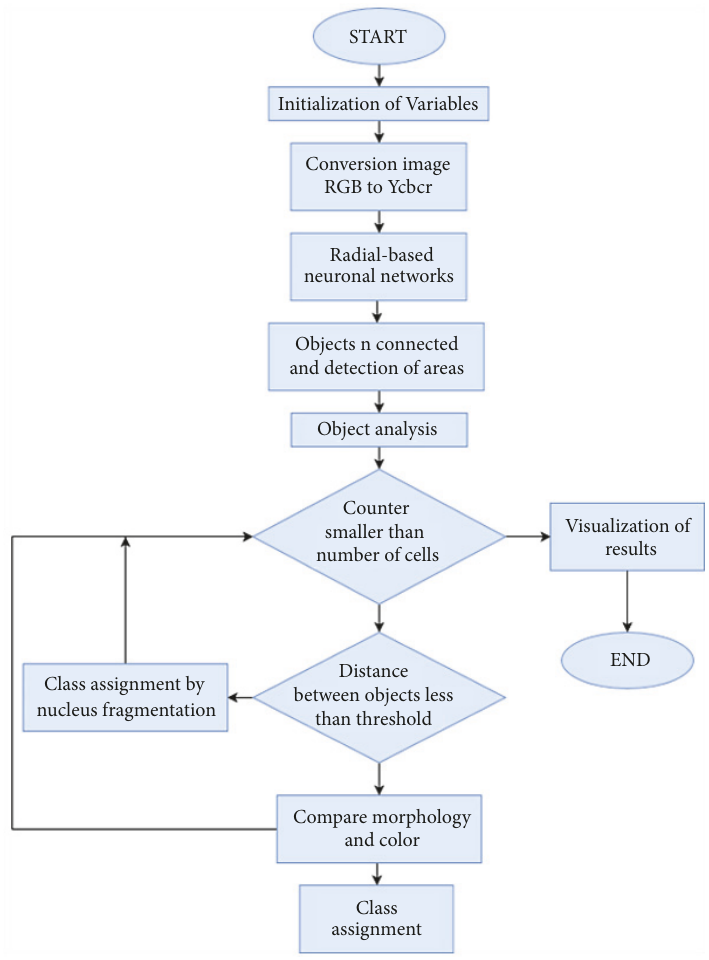
Figure 1: Proposed